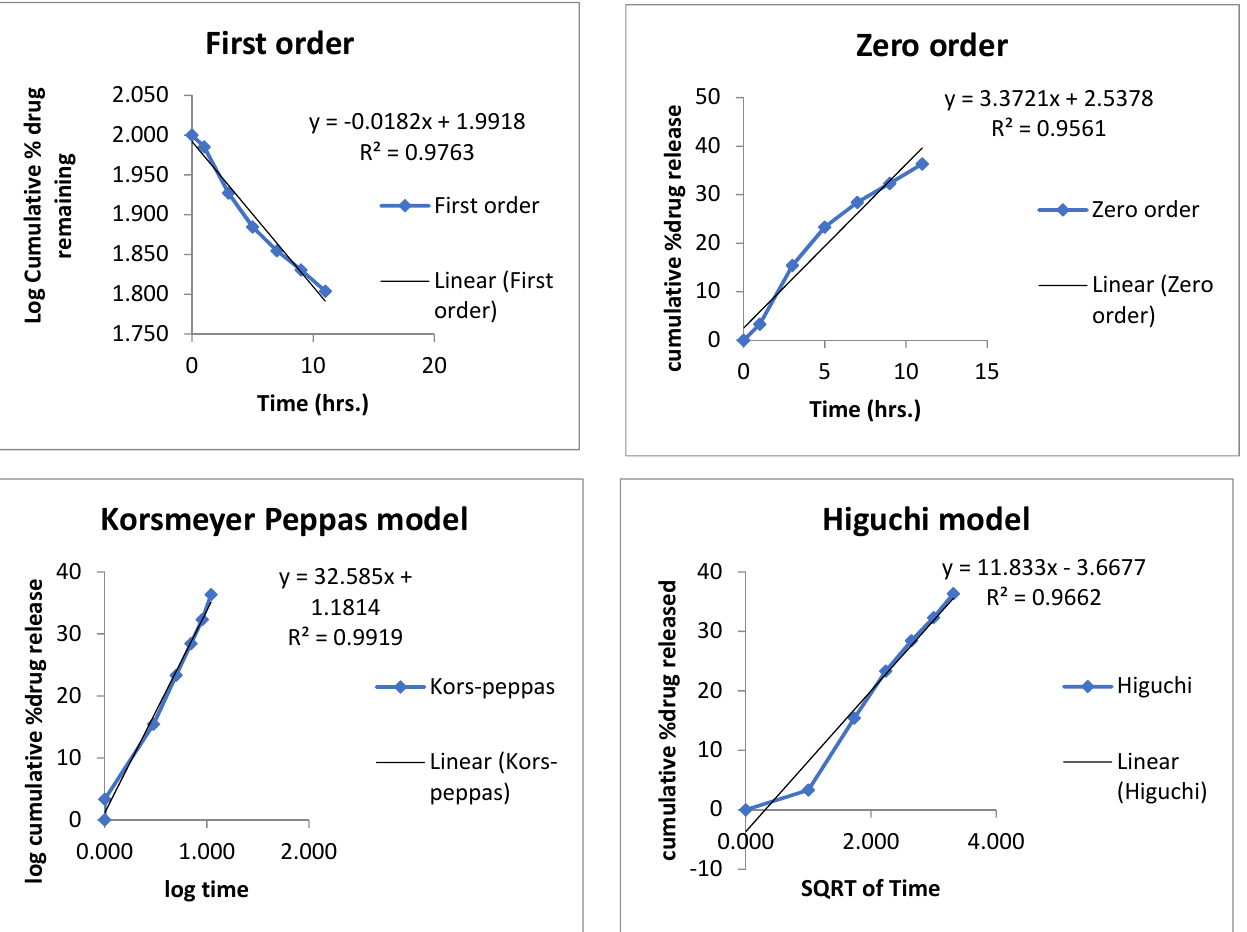
Figure 9. Release mechanism of clove oil from optimized emulsion formulation.